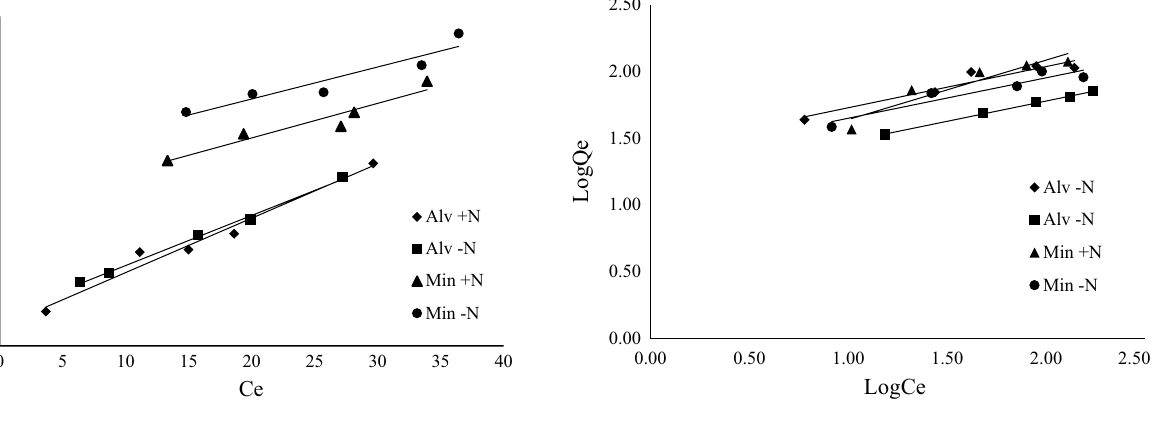
Fig. 11 Freundlich isotherm for lead ions onto N. alveolaris + N, N.